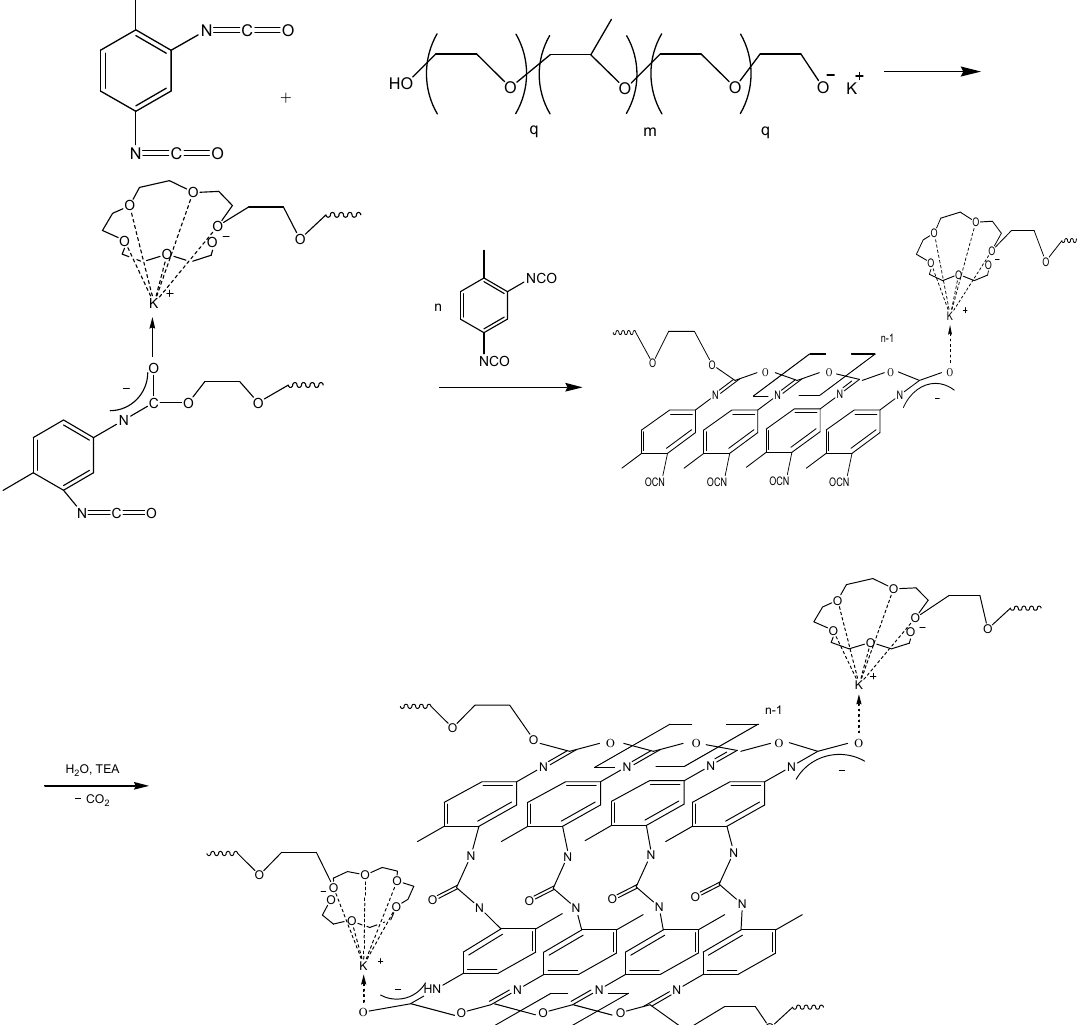
Figure 1. Scheme of O-polyisocyanate blocks formation.